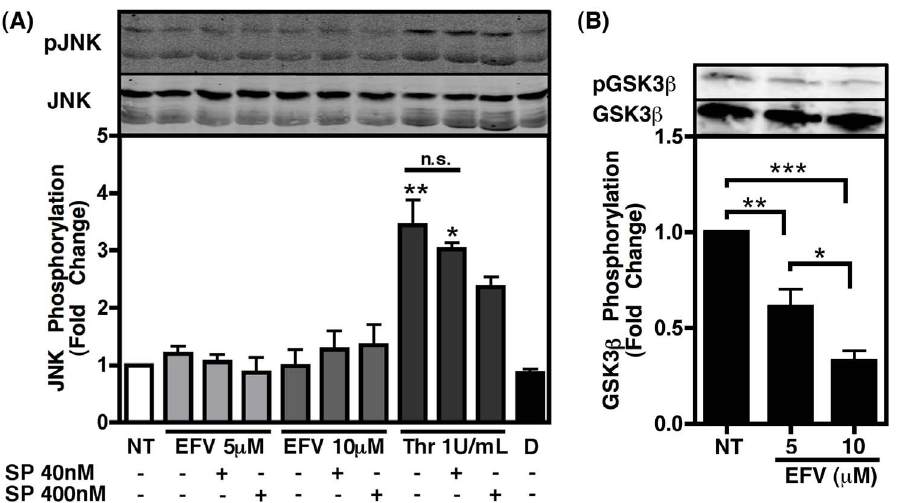
Figure 3. Efavirenz does not alter JNK phosphorylation status in platelets, but does induce activation of GSK3 b . Washed human platelets were treated as indicated for 1 h. Graphs indicate fold change in phosphorylation as compared to non-treated (NT) and determined via densitometry of immunoblots (representative blots shown above corresponding treatments), with phospho -JNK or -GSK3 b quantification determined as a percentage of the total amount of each protein for each sample. (A) EFV does not induce activation of JNK, while thrombin treatment, as a positive control, induced phosphorylation of this kinase, indicating activation. This was partially reversed when treated in the presence of increasing amounts of the JNK inhibitor SP600125 (SP). Values were compared using an one-way ANOVA followed by Bonferroni’s test for multiple comparisons, which indicated statistical significance as *p , 0.05 and **p , 0.01 compared to all other conditions. N.S. indicates not significant; D indicates DMSO as a vehicle control. (B) EFV treatment resulted in dephosphorylation of GSK3 b at the inhibitory phosphorylation site (Ser9), indicating activation of this molecule in platelets. One-way ANOVA followed by Bonferroni’s test for multiple comparisons indicated statistical significance as *p , 0.05, **p , 0.01, and ***p , 0.001.